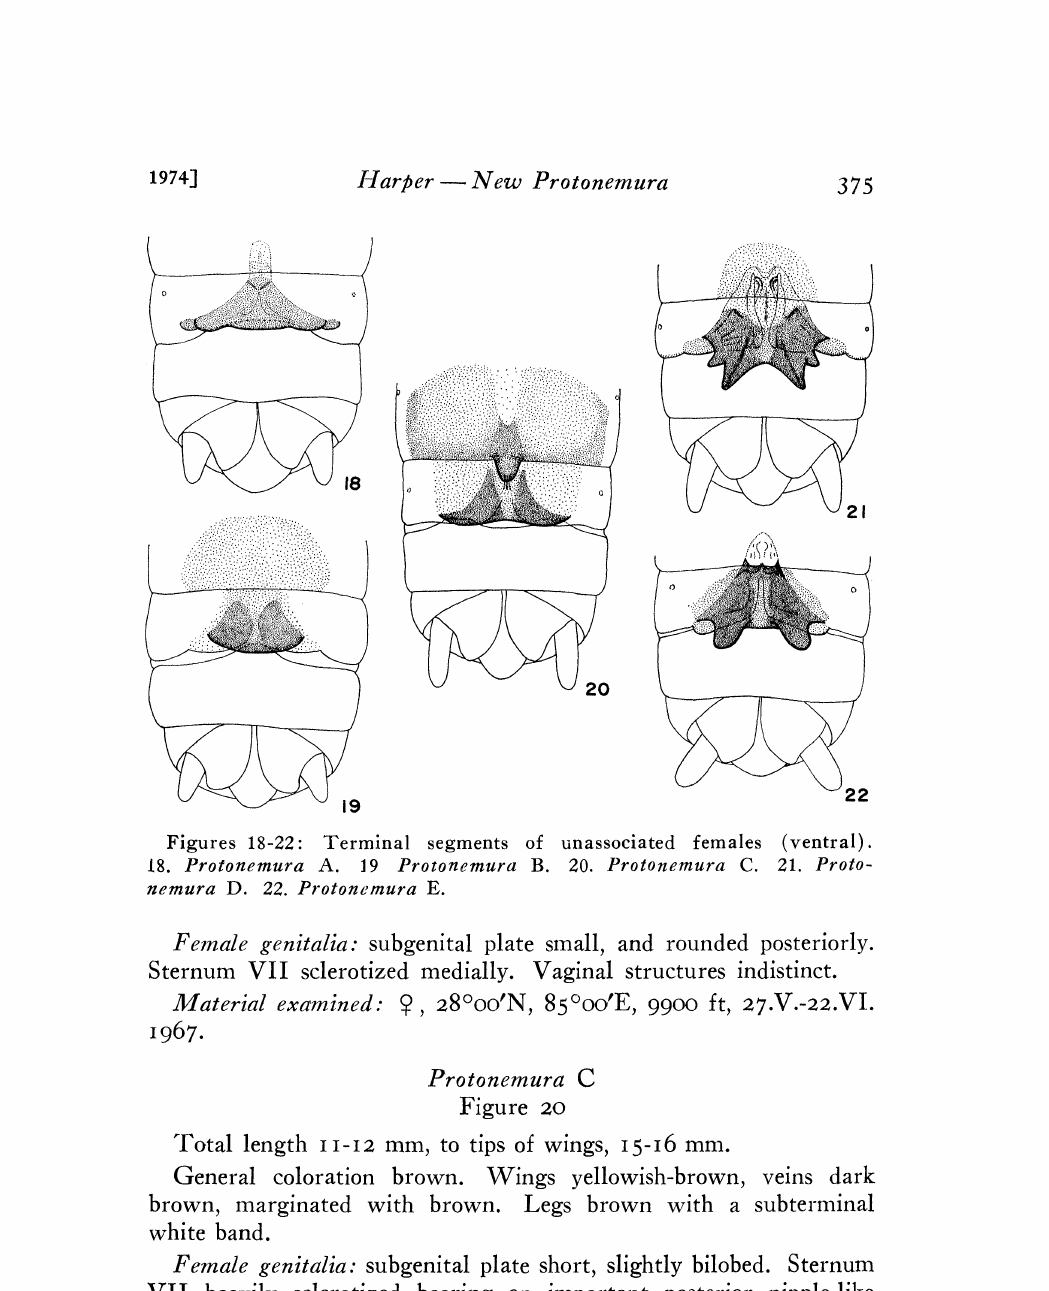
- Total length 2 ram, to tips of wings, 5-6 ram. General coloration brown. Wings yellowish-brown, veins dark brown, marginated with brown. Legs brown with a subterminal white band. Female genitalia: subgenital plate short, slightly bilobed. Sternum VII heavily sclerotized bearing an important posterior nipple-like protuberance. Vaginal structures